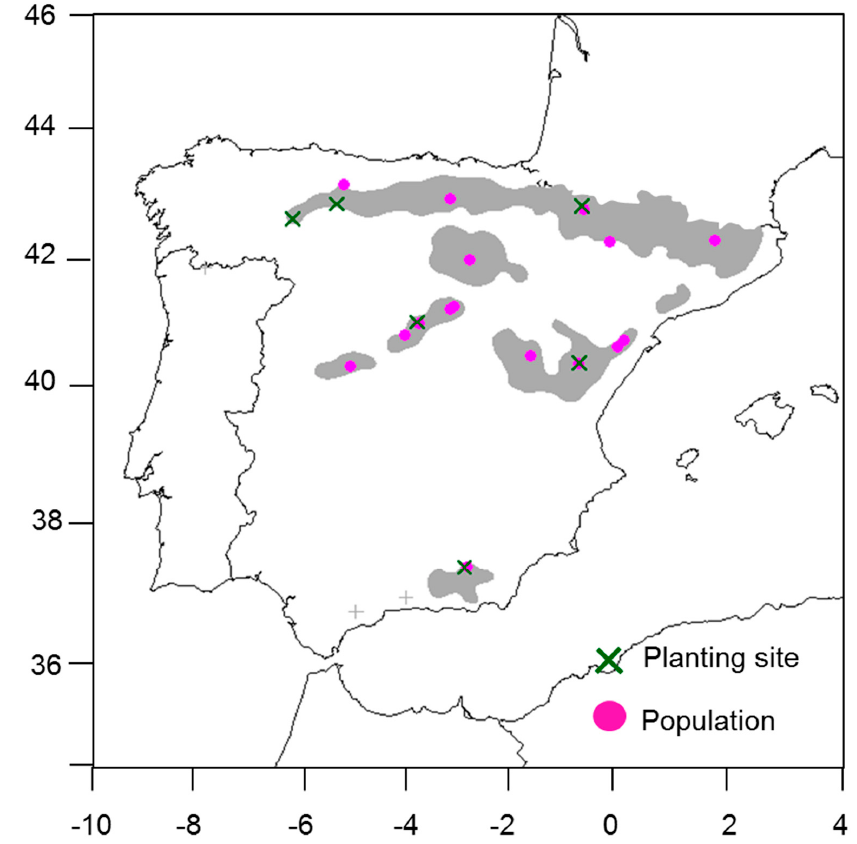
Figure A1. Network of provenance common gardens in Spain (GENFORED): Planting sites (green crosses), populations (pink circles). The species distribution range is shown in gray (two isolated populations are represented by “ + ” in